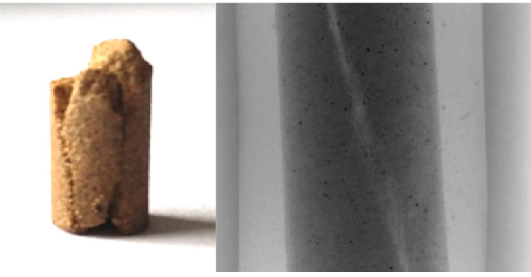
Figure 6: The fractured sandstone